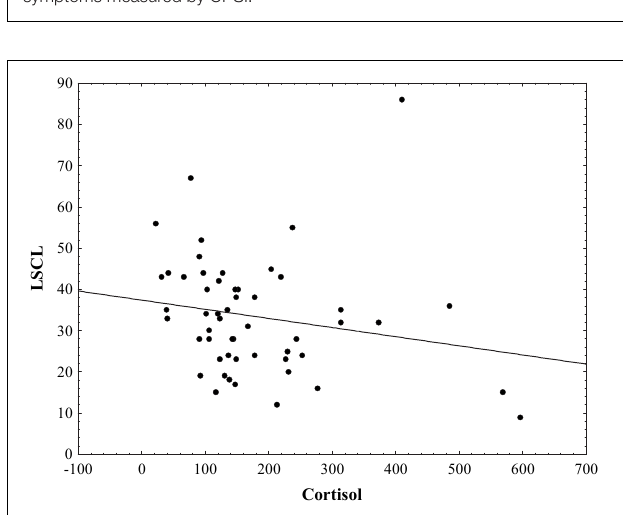
FIGURE 3 | Relationship between hair cortisol levels (pg/mg) and epileptic-like symptoms measured by